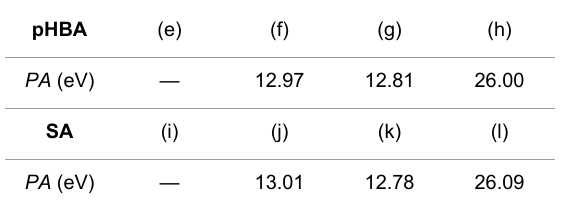
Table 1: Proton affinities of pHBA and SA in neutral and various deprotonated forms, in water, based on DFT calculations at B3LYP/ TZVP level. The labeling corresponds to the one used in Figure 1.